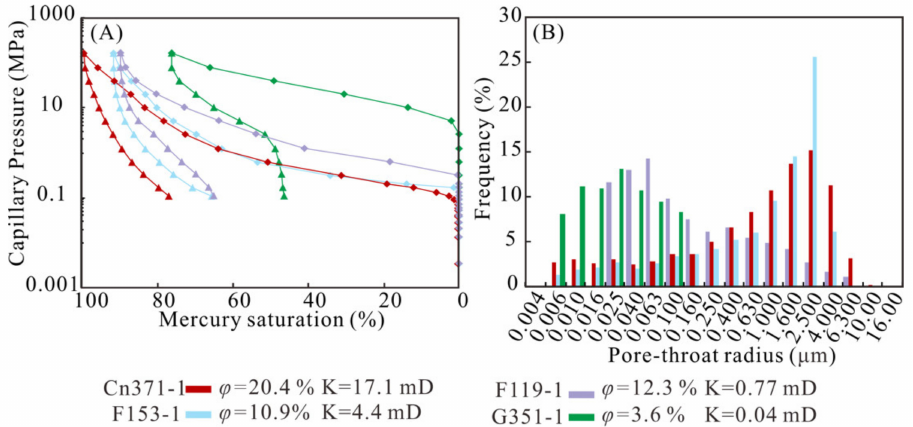
Figure 5. Pore structure characteristics of the E s4 sandstone reservoirs obtained from MICP data. Capillary pressure cures ( A ) and pore throat characteristics ( B ) for four typical samples.